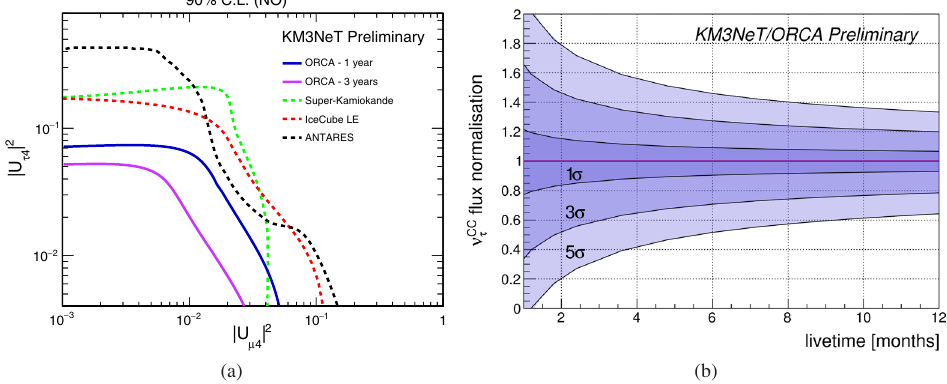
Figure 3 . (a) ORCA sensitivity to a sterile neutrino for 1 and 3 years of data taking com-pared to upper limits from other experiments. (b) Sensitivity to ν τ -flux normalisation for few months of full ORCA detector operation. Figure (b) in Ref.